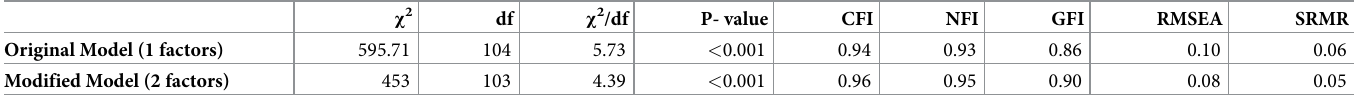
Table 5. Fit indices for one and two factor model